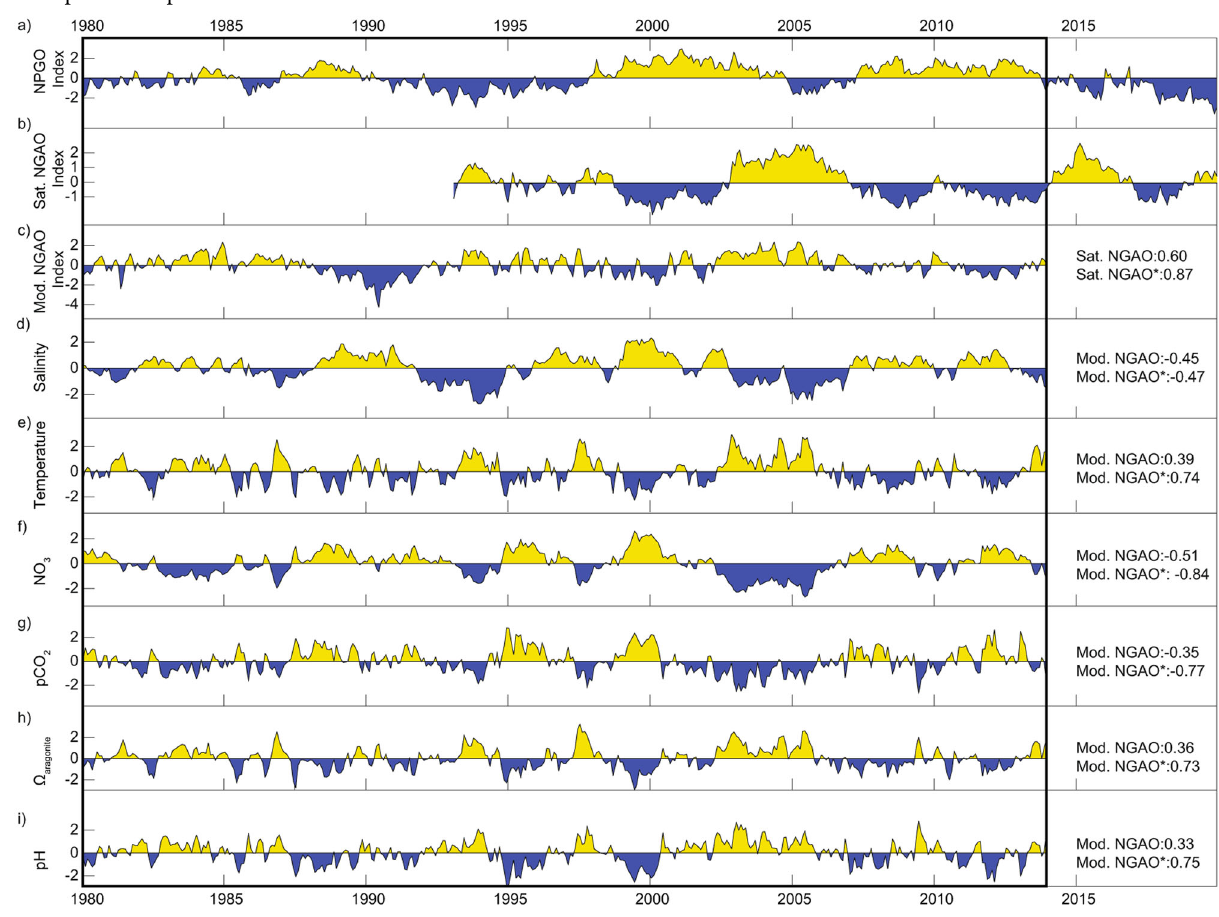
The original version of this Article contained two errors in Fig. 3, in which the number ‘ 8 ’ on the vertical axis on the left hand side of panel ‘ b) ’ was incorrectly coloured red and the number ‘ 3 ’ at the top of the vertical axis on the right hand side of panel ‘ c) ’ was incorrectly coloured black. In the correct version of Fig. 3 the number ‘ 8 ’ on the vertical axis on the left hand side of panel ‘ b) ’ is coloured black and the number ‘ 3 ’ at the top of the vertical axis on the right hand side of panel ‘ c) ’ is coloured blue. This has been corrected in both the PDF and HTML versions of the